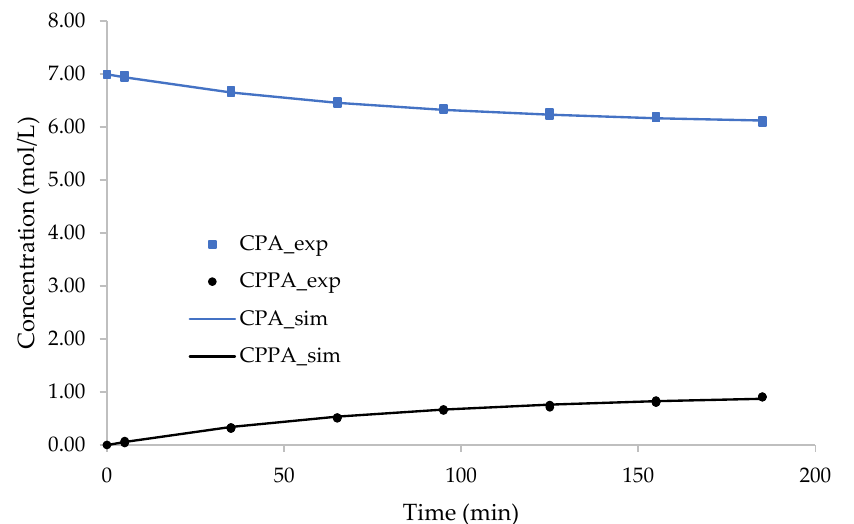
Figure 10. The fit of the model to experimental concentrations for Run 6. (PPA: perpropionic acid and PA: propionic acid).